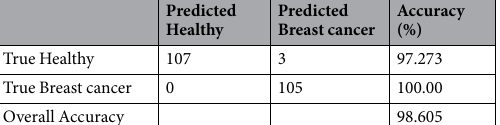
Table 2. Summary report of PLS-DA Model generated on MPPfrom healthy controls (n = 100) and breast cancer patients (n = 105). PLS-DA – Partial Least Square Discriminant Analysis, MPP – Mass Profiler Professional.